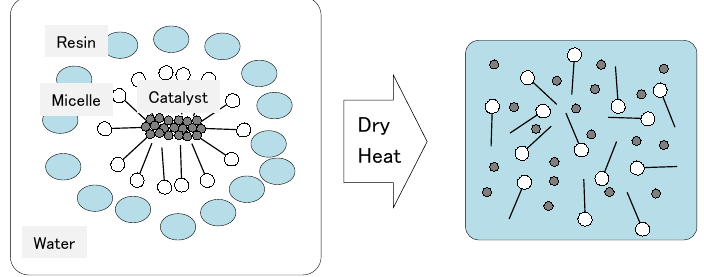
Figure 1. A catalyst encapsulated in a micelle in surfactant solution.